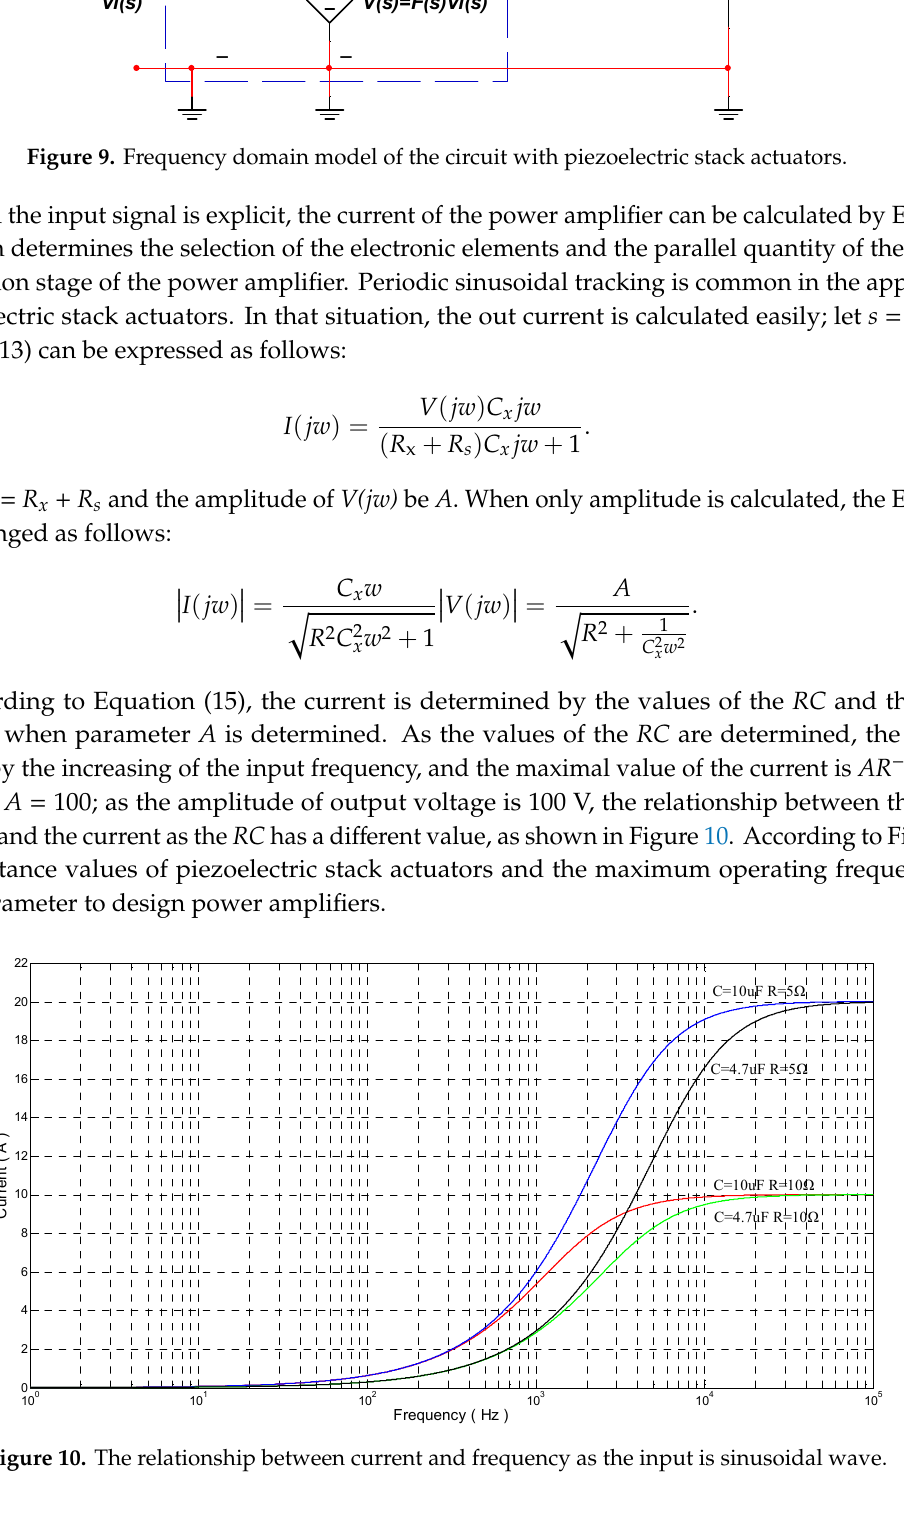
Figure 10. The relationship between current and frequency as the input is sinusoidal wave.